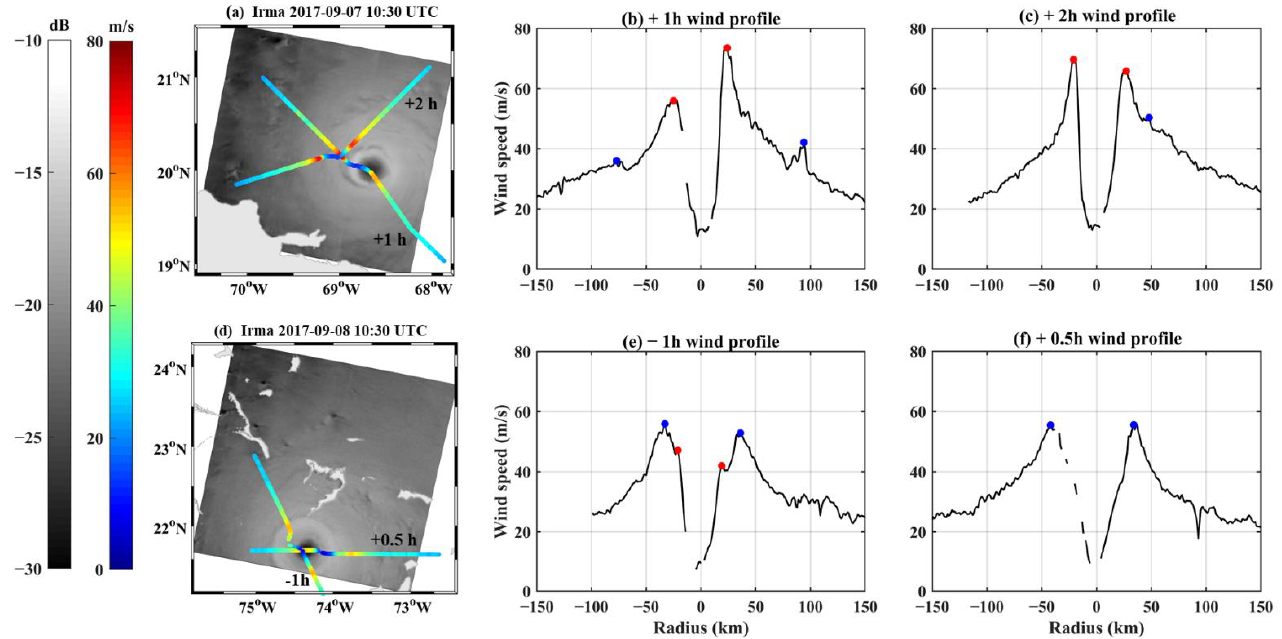
Figure 10. ( a , d ) SAR images containing Irma’s inner core overlayed with two complete wind profiles closest to the SAR acquisition times. The color bars denote σ 0 (unit: dB) and the sea-surface wind (unit: m/s) derived from SFMR, respectively. ( b , c , e , f ) Complete wind profiles along the tracks nearest the SAR acquisition times at sea-surface level. The red and blue dots represent the locations of inner and outer eyewalls, respectively. RADARSAT-2 Data and Products MacDonald, Dettwiler, and Associates Ltd. (2008 – 2009).